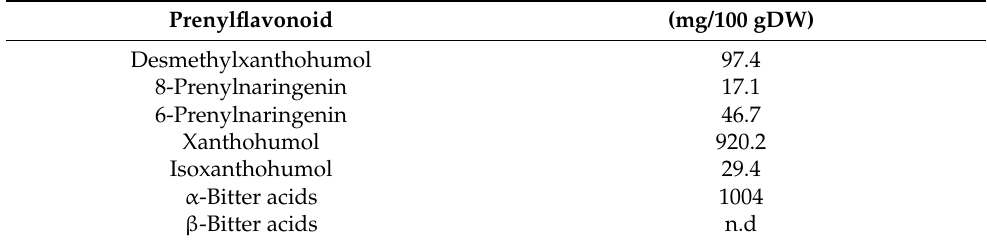
Table 1. Characterization of the starting hop